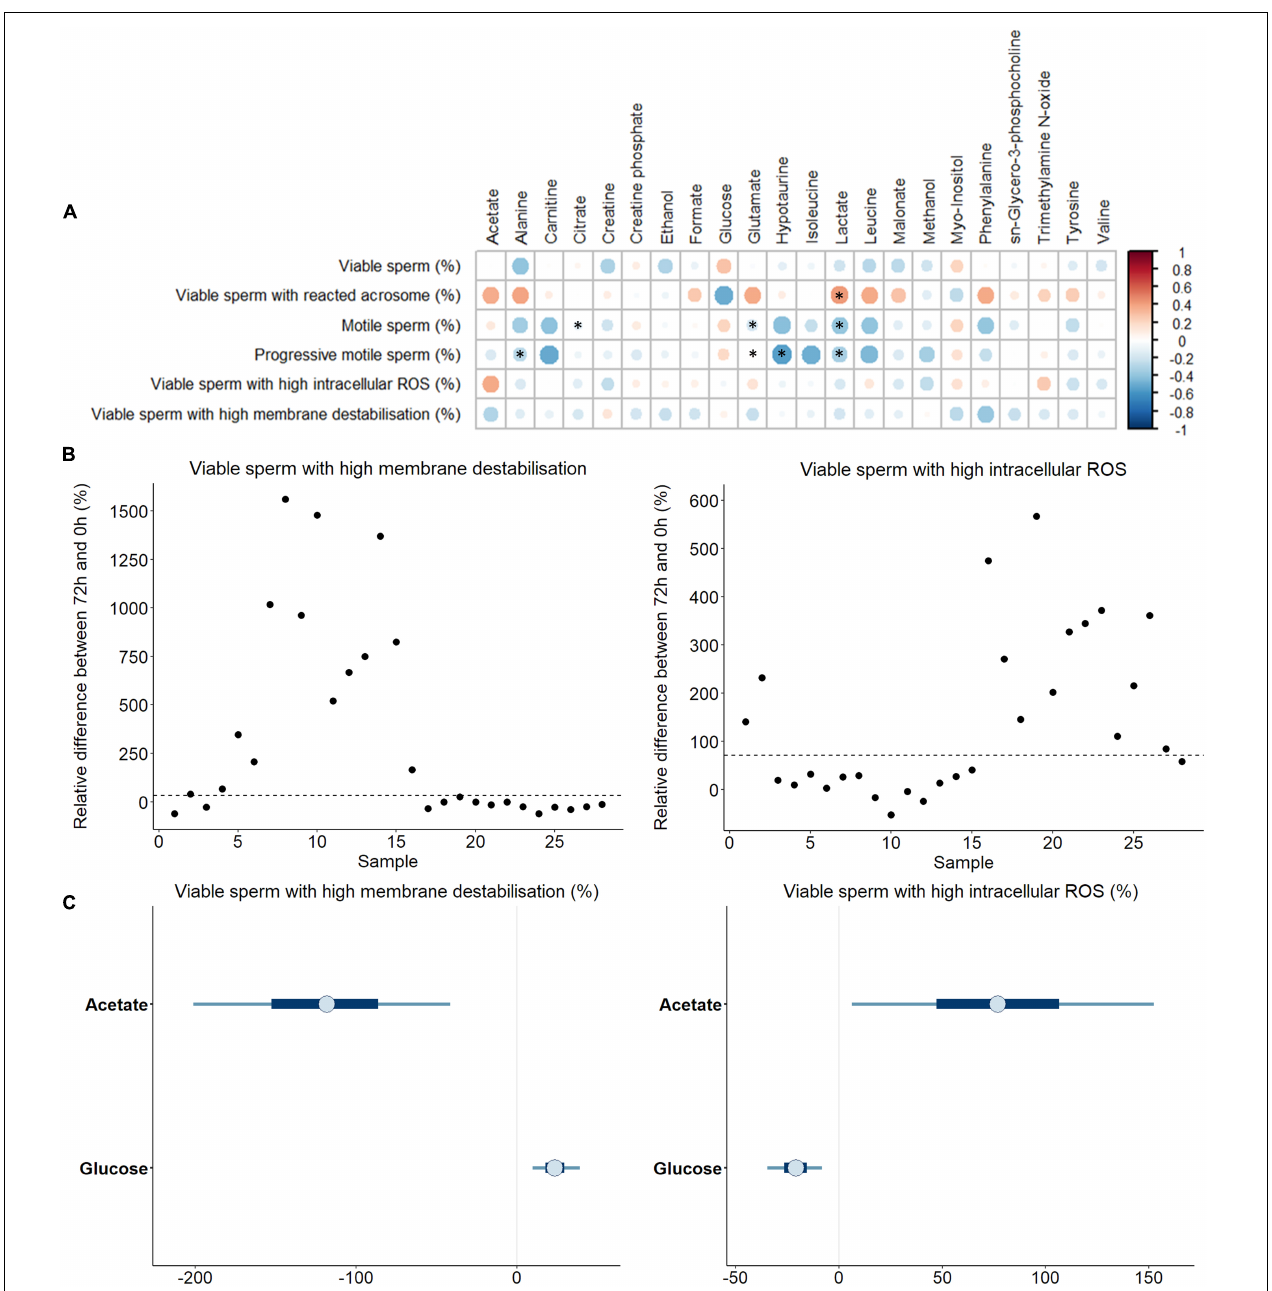
FIGURE 4 | (A) Correlations between metabolites identified in pig seminal plasma and different sperm quality and functionality parameters evaluating the quality loss after 72 h of liquid storage at 17 ◦ C. The color saturation of red to blue represents the correlation coefficients (R) between metabolites, from 1 to − 1, respectively. Significant correlations ( P < 0.05) are marked with *. (B) Plot showing the relative differences of viable sperm with high membrane destabilization and with high intracellular reactive oxygen species, ROS (H 2 O 2 ) for each SP sample. Two different sperm resilience to liquid storage patterns can be observed (marked with a discontinuous line). (C) Bayesian logistic regression models for the percentage viable sperm with high membrane destabilization and with high intracellular H 2 O 2 . Thin lines represent the 90% credible intervals, and the blue box represents the 50% credible intervals. Dots represent the median estimated for each metabolite in the